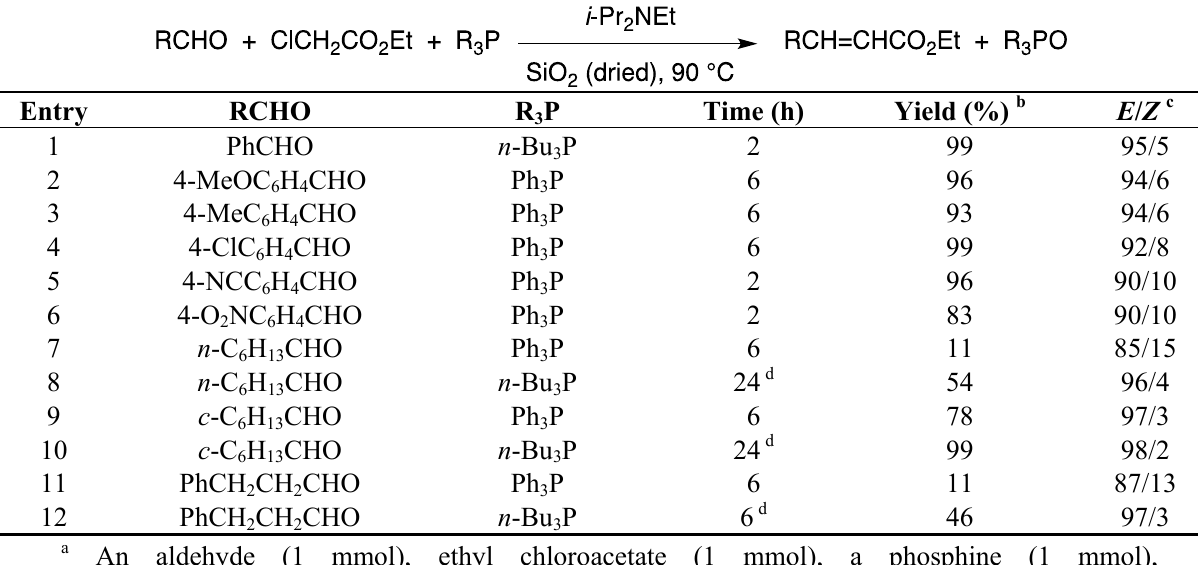
Table 5. One-pot Wittig-type olefination of various aldehydes on silica gel a